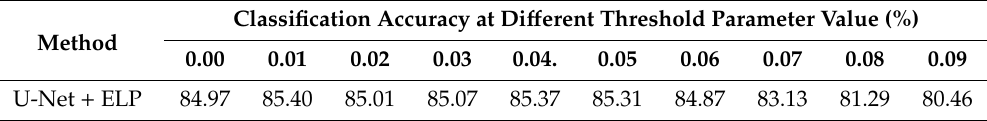
Table 8. Classification accuracy comparison of di ff erent threshold values α .